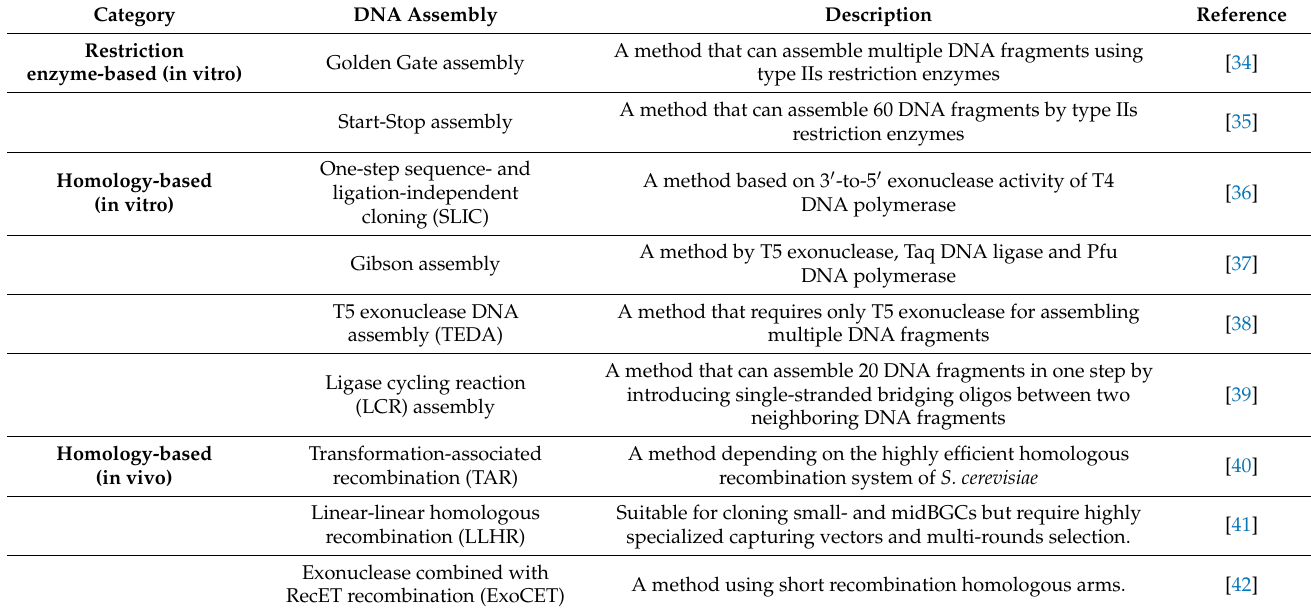
Table 2. Experimental strategies in the construction of chassis cells for natural